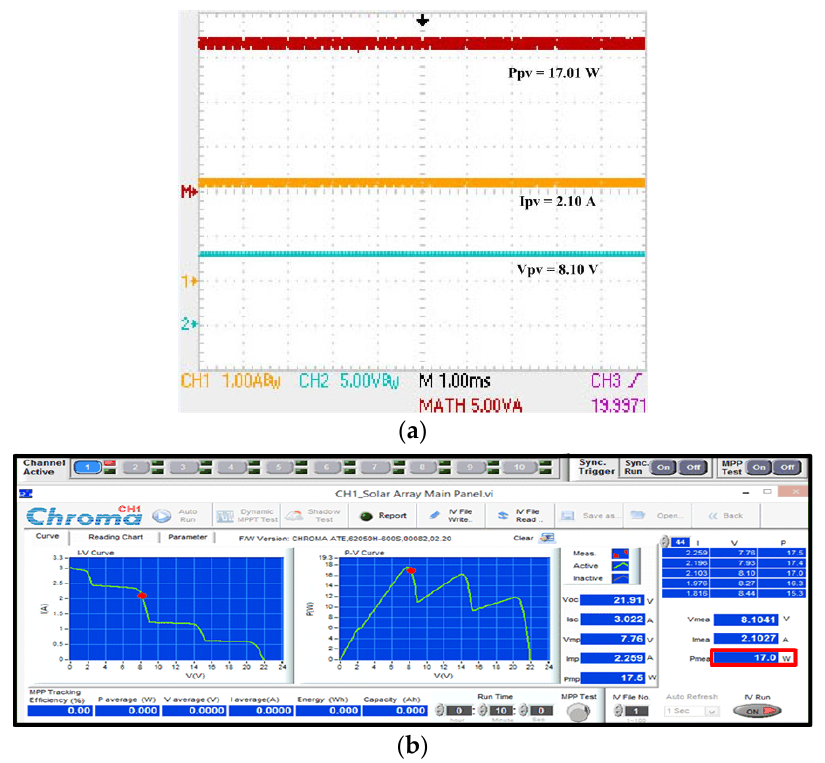
Figure 23. Experimental results under PSC 1 of the proposed modified LFO, ( a ), ( b ), ( c ) reflect same result.